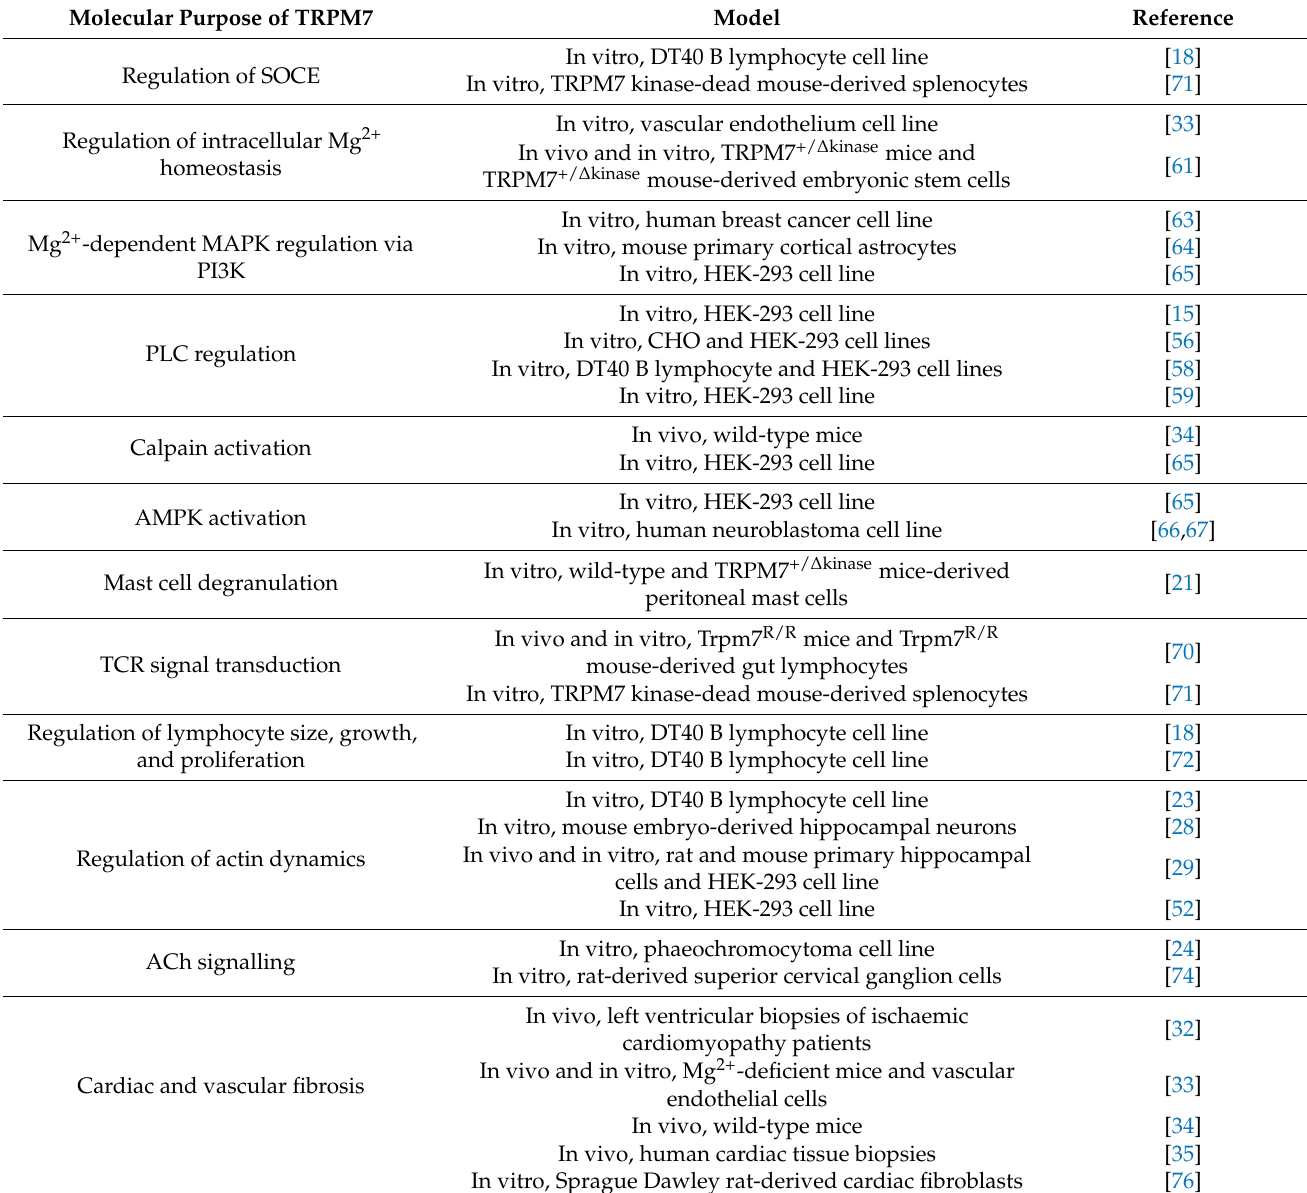
Table 1. Cellular, physiological, and pathophysiological roles of TRPM7. Abbreviations: ACh (acetylcholine), AMPK (adenosine monophosphate-activated protein kinase), CHO (Chinese hamster ovary), HEK (human embryonic kidney), MAPK (mitogen-activated protein kinase), Mg 2+ (magnesium), PI3K (phosphoinositide 3-kinase), PLC (phospholipase C), TCR (T cell receptor), TRPM7 (transient receptor potential melastatin 7), TRPM7 +/ ∆ kinase (heterozygous TRPM7